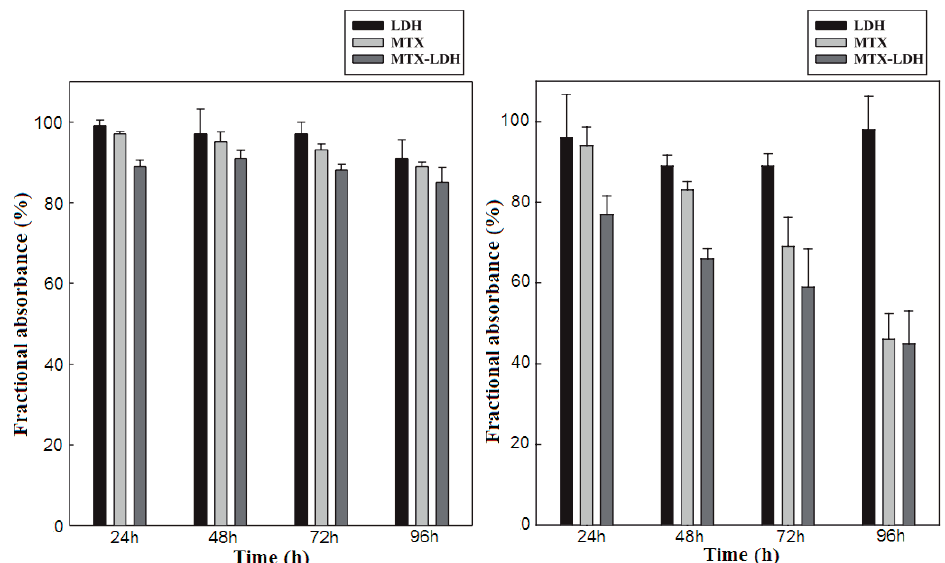
Figure 12. The effect of methotrexate MTX–LDH on normal ( Left ) and tumor ( Right ) cell growth at the concentration of 5.0 μ g·mL − 1 . Reprinted with permission from [48] (Copyright 2004 Elsevier).